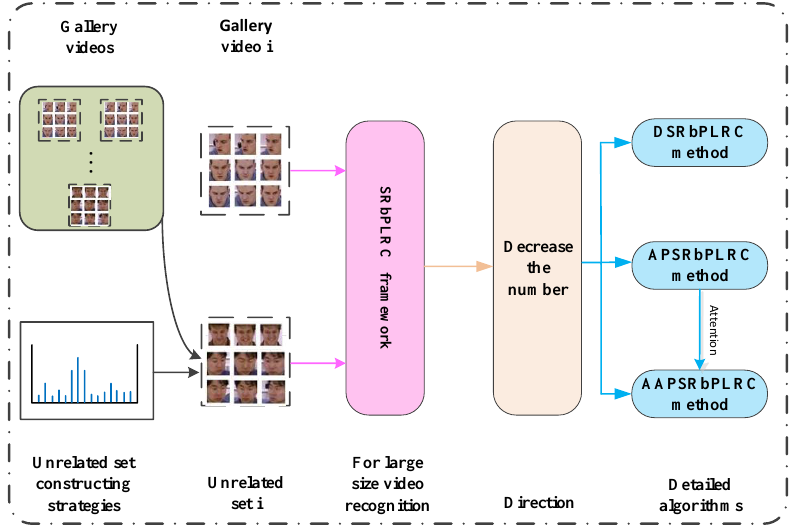
Figure 1. An illustration of the proposed framework. Aiming at obtaining an effective and efficient video face recognition method, a new SRbPLRC framework is proposed, by decreasing the number of images in each video. This framework contains DSRbPLRC, APSRbPLRC, and AAPSRbPLRC